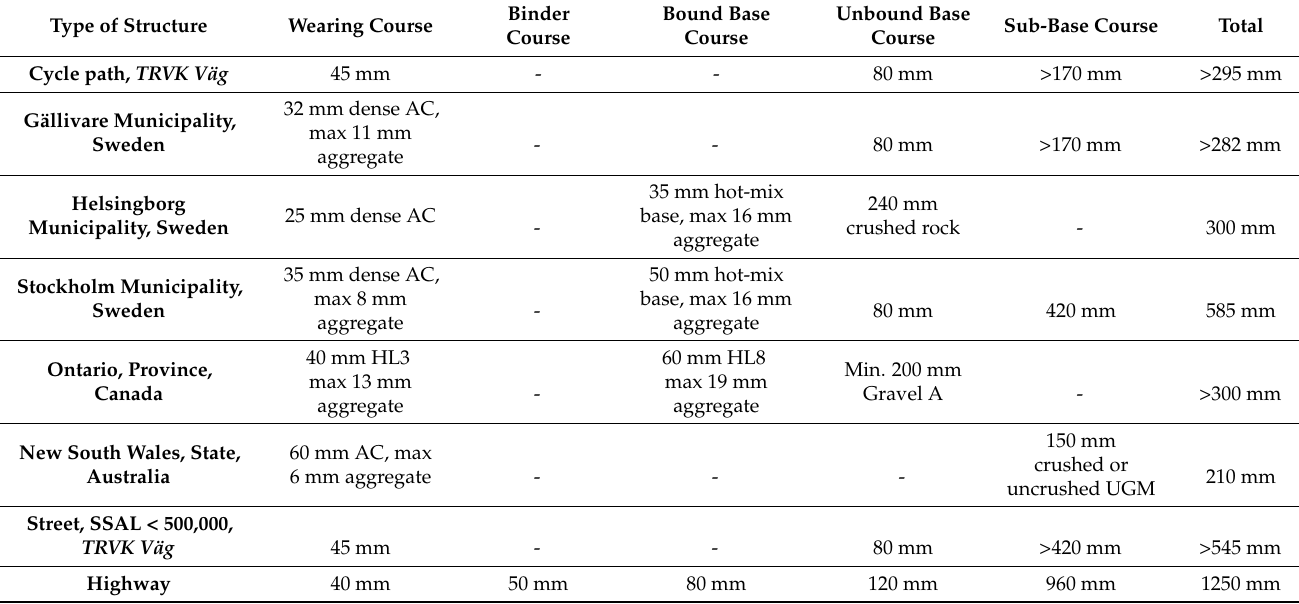
Table 1. Designs of superstructures with respect to layer thickness and materials for typical cycle paths, streets, and highways. The cycle paths represent the superstructures in TRVK Väg for small, middle-sized, and large municipalities in Sweden, and reference examples from Canada and Australia to represent cold and temperate climate conditions,